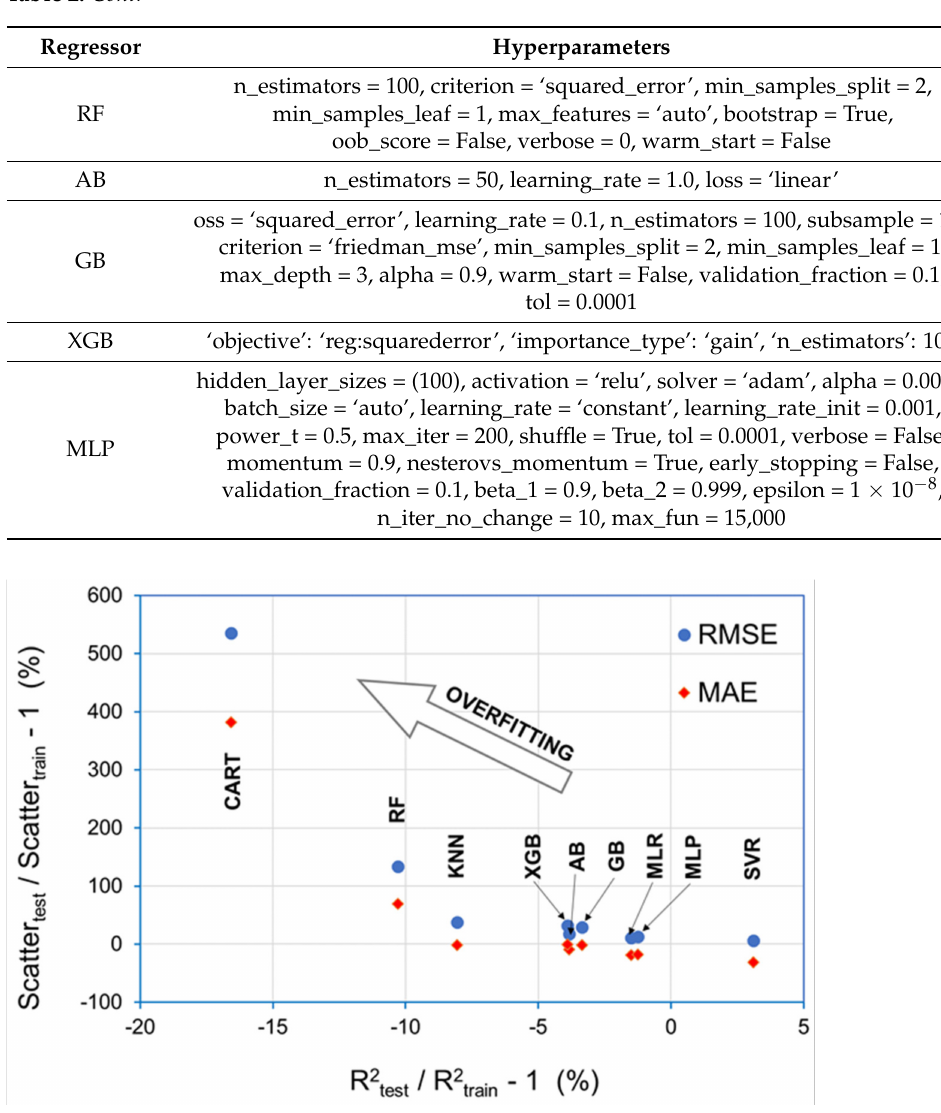
Figure 5. This scatterplot provides an estimation of the relative performance between the test and train datasets in terms of the coefficient of determination and the two scores employed to measure the scatter, the RMSE and MAE, respectively. The arrow superimposed on the figure shows the direction of increasing